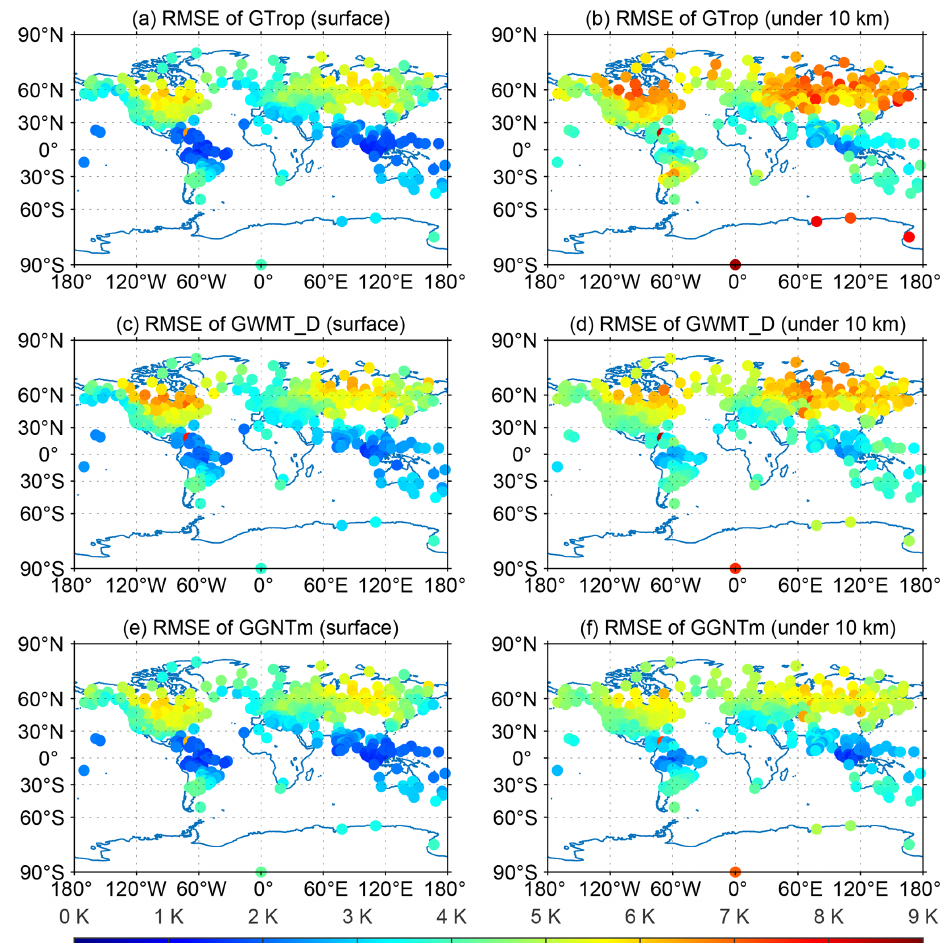
Figure 7. RMSE of T m at surface level (a, c, e) and all pressure levels under 10km (b, d, f) at each of the 428 radiosonde stations in 2018 resulting from GTrop, GWMT_D, and GGNTm. The RMSE of T m under 10km was calculated using the differences between model- predicted T m values and the T m values over all pressure levels with a height of less than